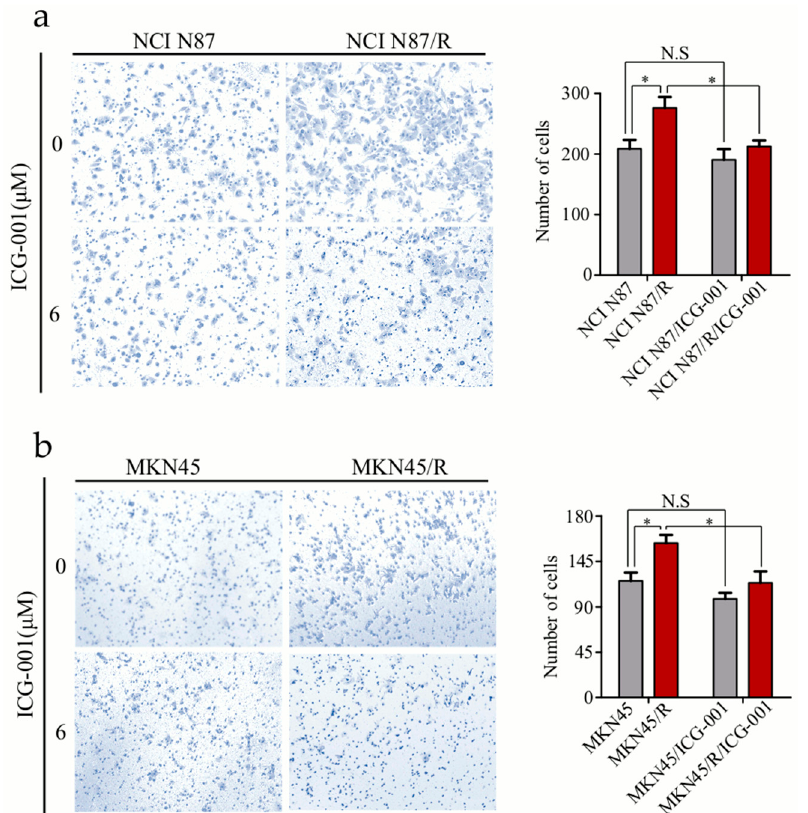
Figure 6. ICG-001 inhibits invasion of trastuzumab resistant cells. Cells were cultured with or without ICG-001 under indicated concentrations, and their invasive ability was evaluated by transwell assay. ( a , b ) (Left panels) Representative image of cell invasion (original magnification 100 × ). ( a , b ) (Right panels) Quantitative results of invasion assays, the results are expressed as mean ± SEM of three independent experiments. * p < 0.05 vs. controls. N.S = no statistical significance.